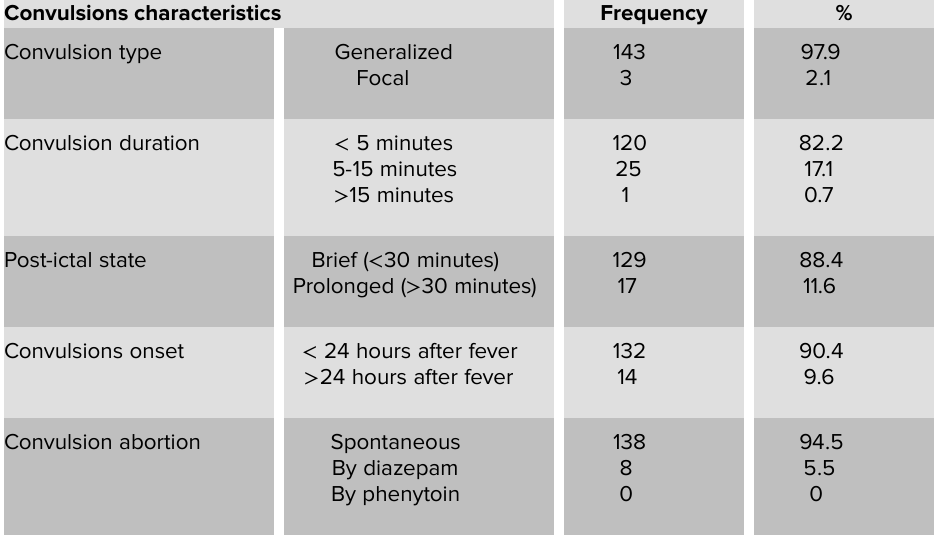
Table 3: Distribution of the study population according to convulsions characteristics (n= 146).